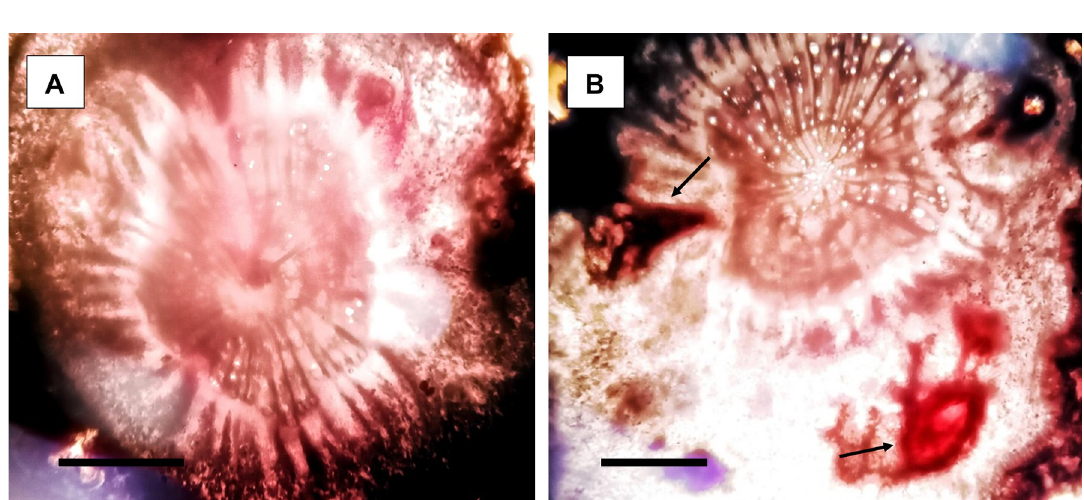
Fig 7. P . lilacinum mitigates the damage to root tissues caused by M . incognita . Transverse section of the eggplant roots inoculated with M . incognita with (A) or without (B) preinoculation of P . lilacinum . The arrows indicate the females of M . incognita . present in the root tissue. Bar = 0.5